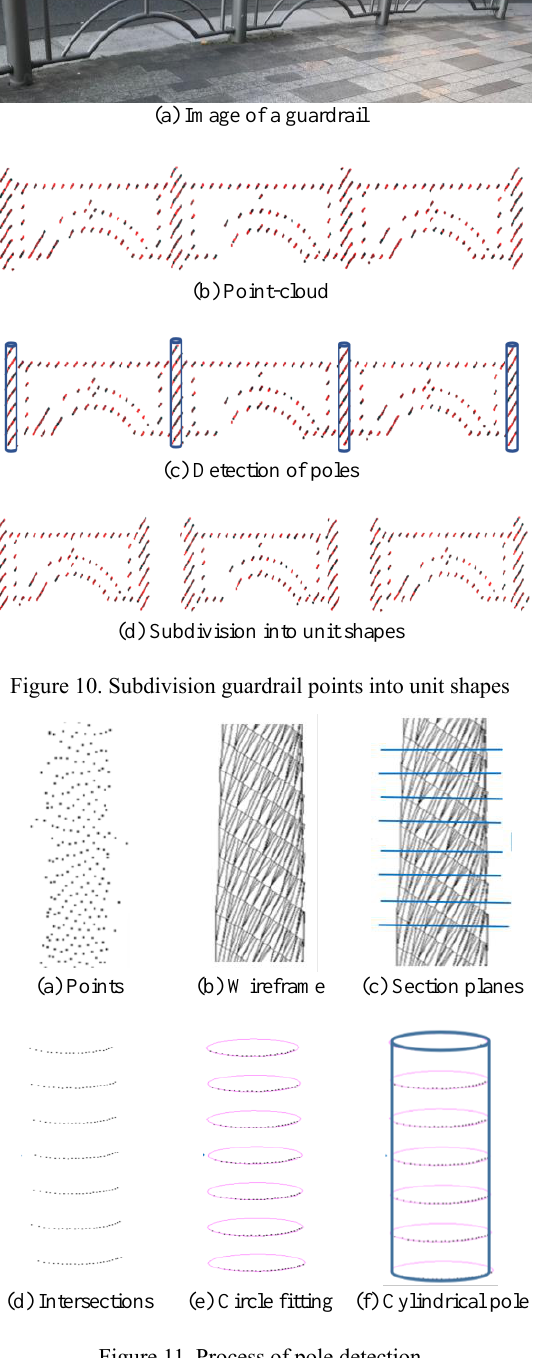
Figure 11. Process of pole detection